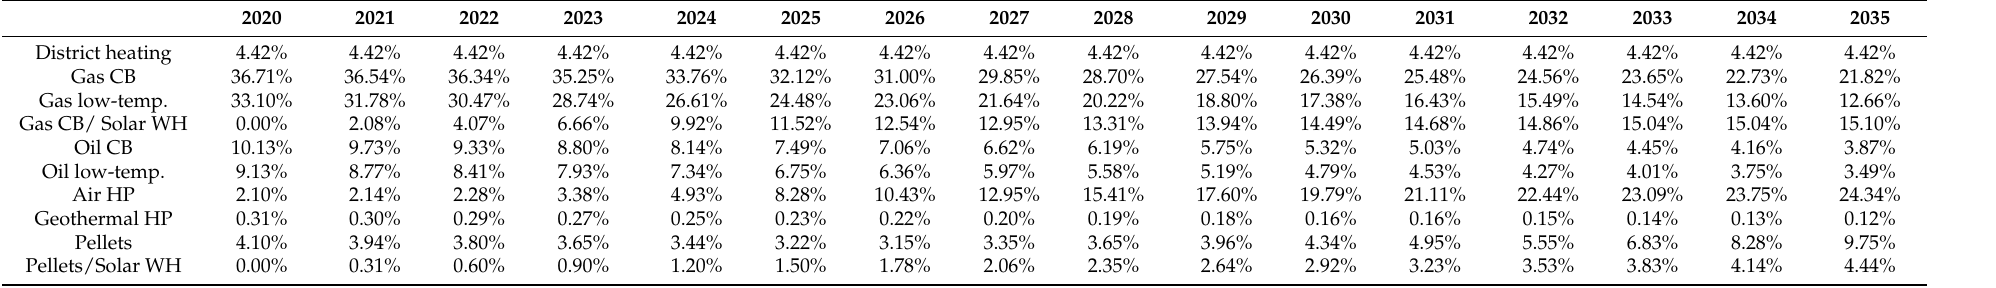
Table A3. Share of technologies in the ‘Additional Incentive Programme Lower